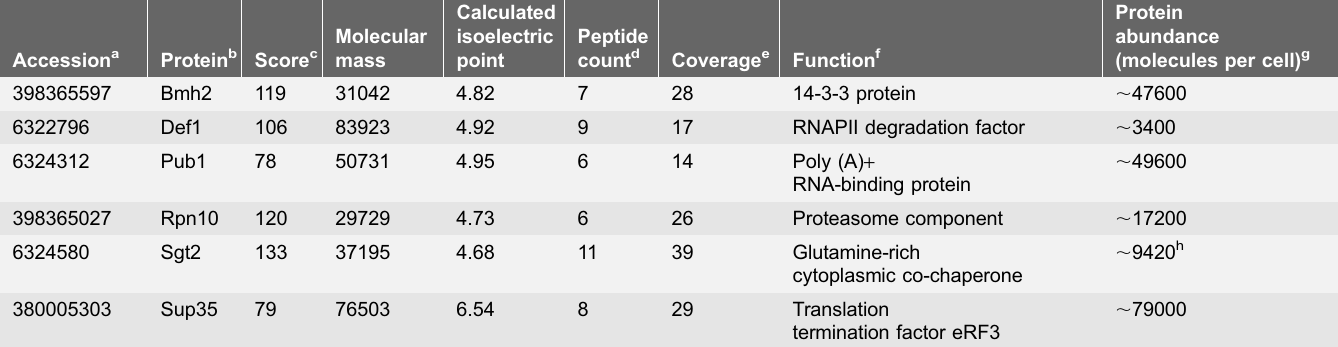
Table 5. Identification of proteins that polymerize in the presence of huntingtin aggregates.